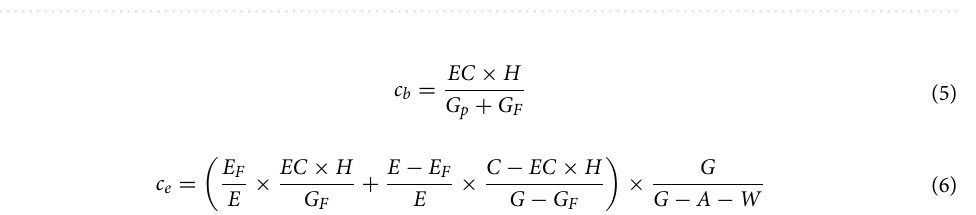
Figure 2. Ecological footprint of biological resource accounts in Guangdong Province from 2013 to 2018 (hm 2